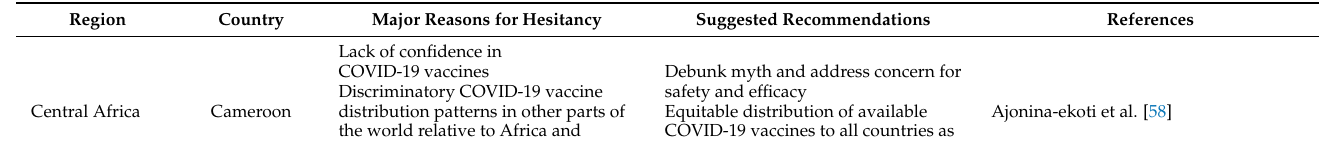
Table 4. Major reasons for COVID-19 vaccine hesitancy in some African countries and the suggested